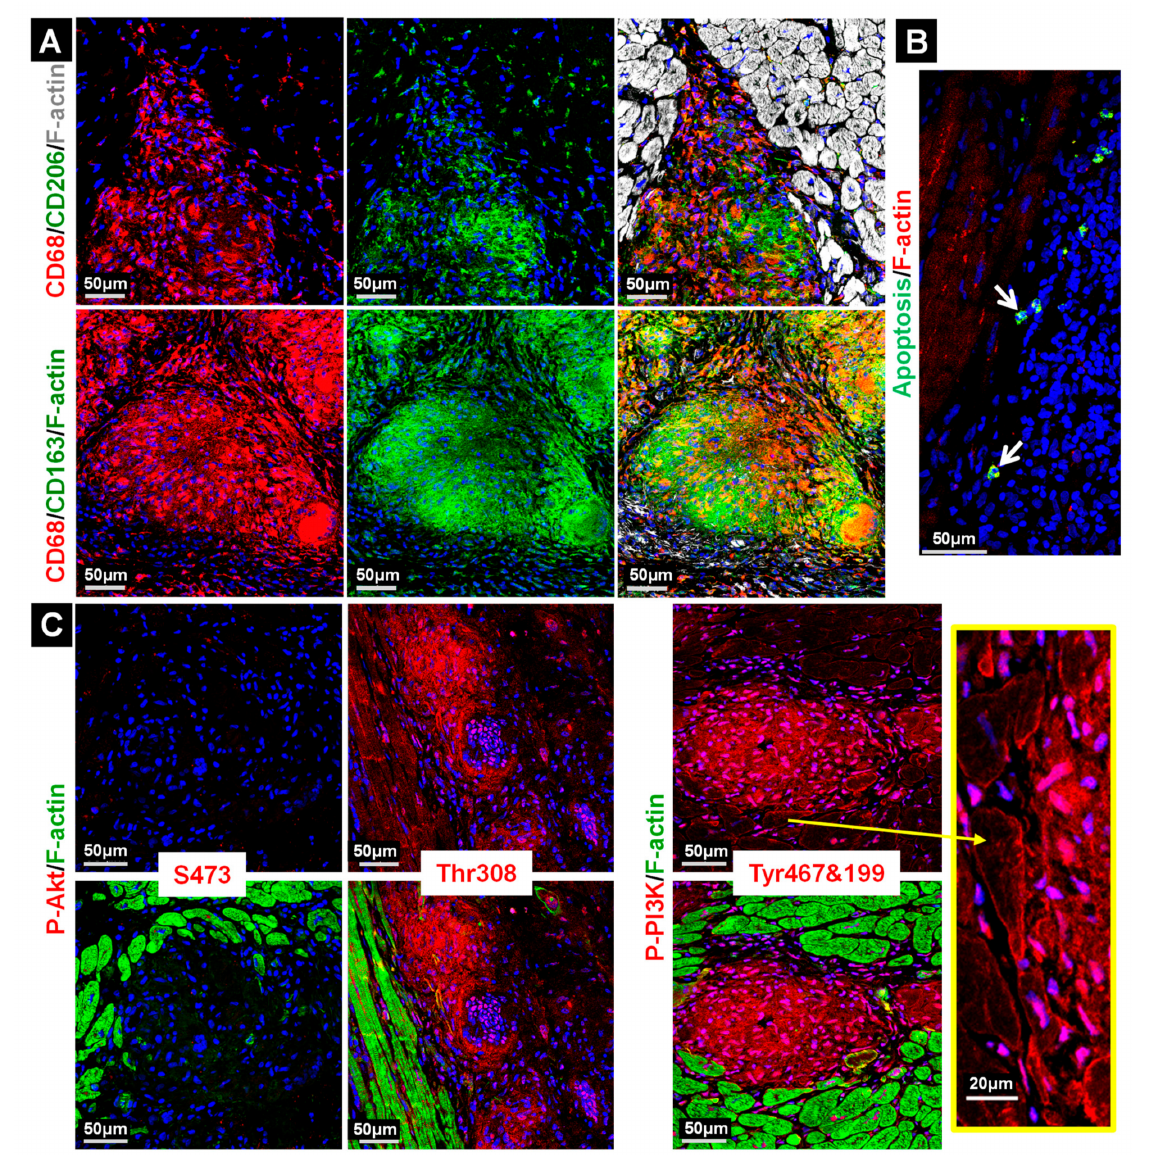
Figure 2. The PI3 kinase pathway is activated in macrophages of the granuloma and show mild apoptosis. ( A ) Confocal images of CD68 + /CD163 + /CD206 + stains demonstrate that the major cell pool in the granuloma consists of macrophages. ( B ) Mildly apoptotic cells were identified and are mainly located outside the granuloma. ( C ) The phosphoinositide 3-kinase (P-PI3K) and P-Akt/PKB (P-Akt) survival pathway is activated. Mainly threonine 308 (Thr308) but little serine 473 (S473) of the Akt kinase (P-Akt) is phosphorylated in granuloma. Phospho-sites are specified. Note that also surrounding cardiomyocytes show a PI3K activation (yellow arrow and enlarged yellow frame). The nuclei are stained blue with